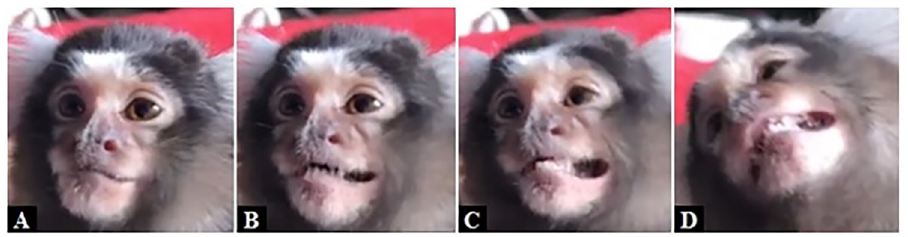
Fig 15. AU16—Lower Lip Depressor. A : Neutral; B : AU16 pulls the lower lip downwards medially and laterally (AU12 also present); C : AU16 pulls the lower lip further down laterally (AU110+AU12 also present); D : AU16 pulls the whole lower lip further down (AU110+AU12 also present).